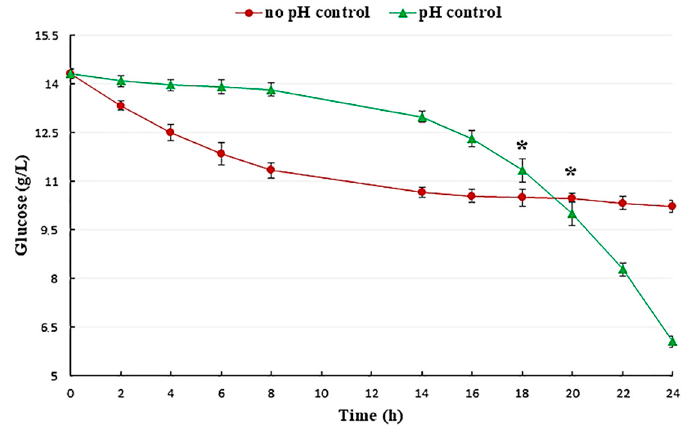
Figure 2. Glucose concentration during the fermentation process. (Student’s t -test provided p < 0.05 for all points, except for the glucose values at 18 and 20 h, marked with asterisks,